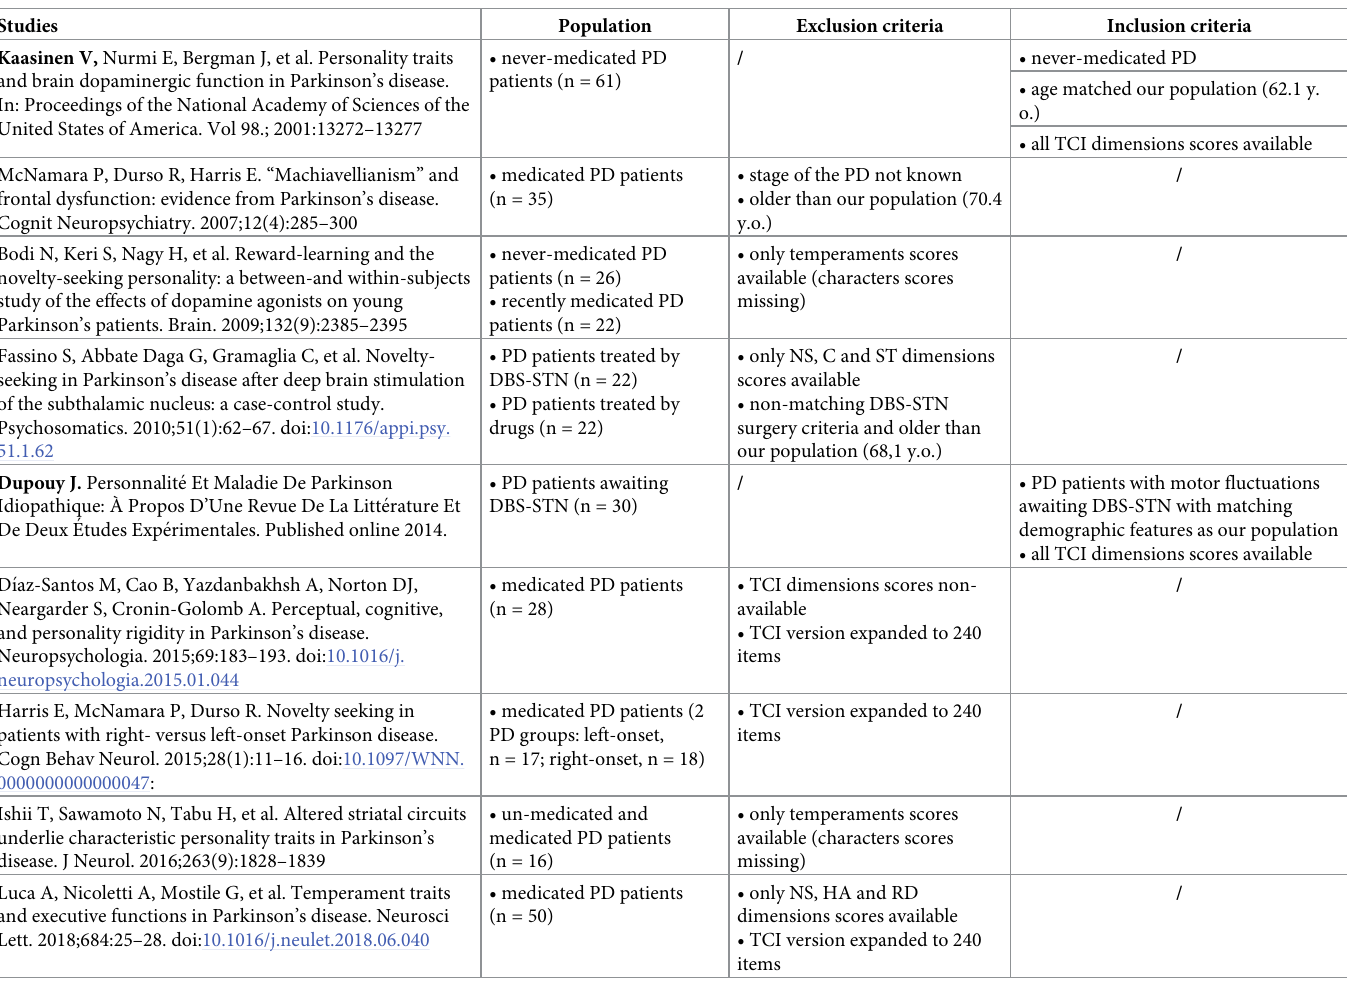
Table 1. Selection criteria of studies on personality in PD